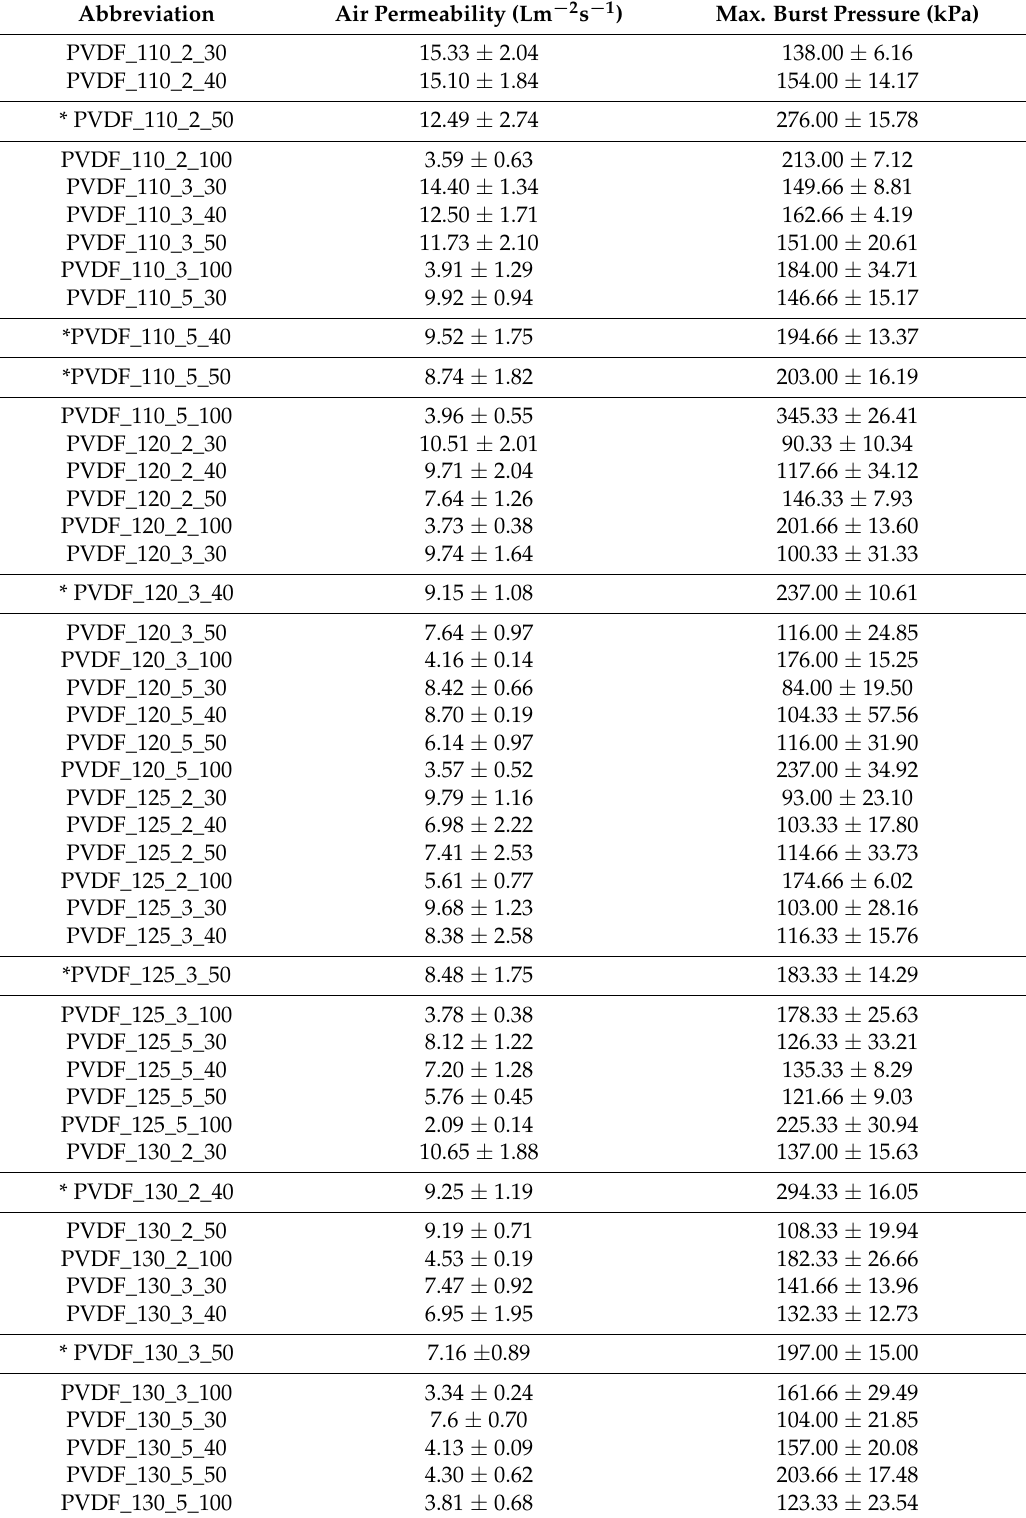
Table A2. Air permeability and maximum burst pressure of the